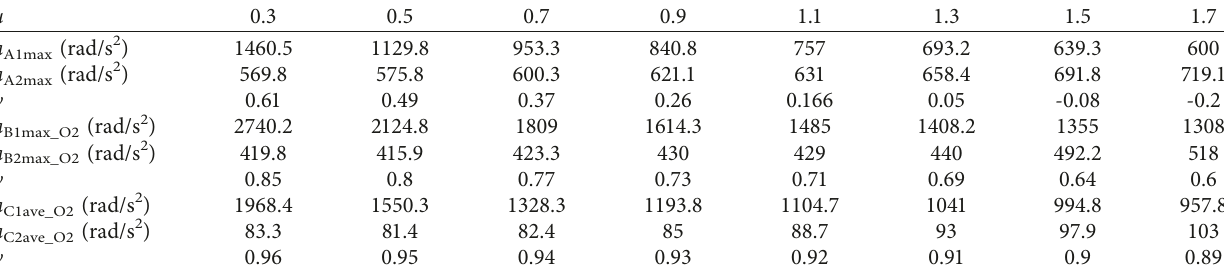
Figure 12: The 2 nd order angular acceleration under different μ values in Phases B and C. (a) The primary side result; (b) the secondary side result. Table 3: DMF vibration control performances under different μ